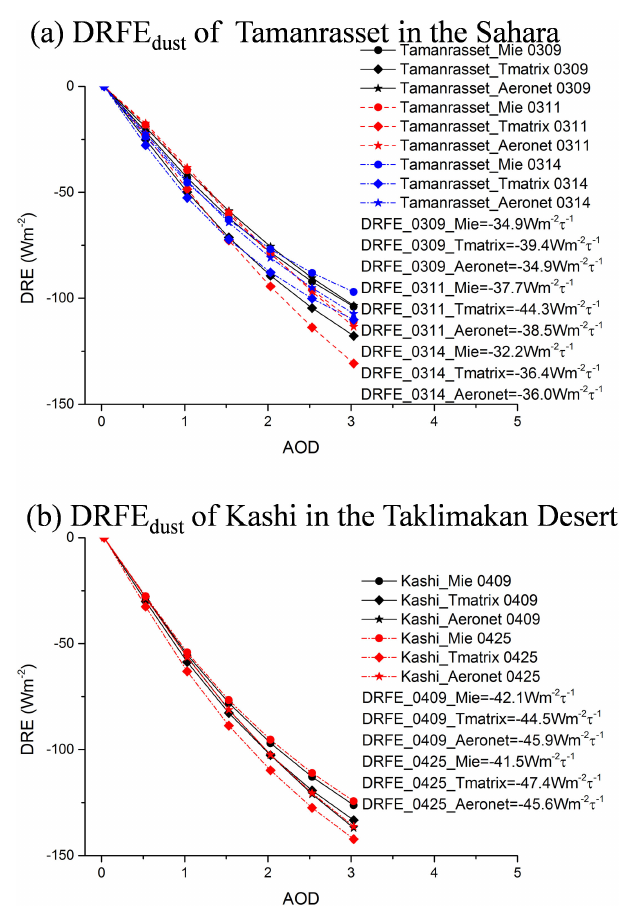
Figure 15. DRFE dust simulated by SBDART over (a) Tamanrasset in the Sahara and (b) Kashi in the Taklimakan